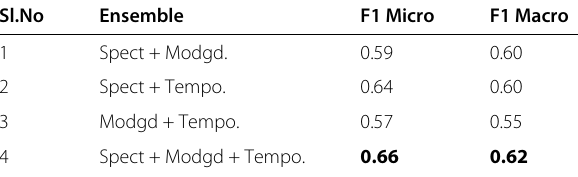
Table 6 Ablation study of ensemble with data augmentation. Spect, Modgd, and Tempo refer to Mel-spectrogram-Swin-T, Modgdgram-Swin-T, and Tempogram-Swin-T, respectively. + denotes soft voting